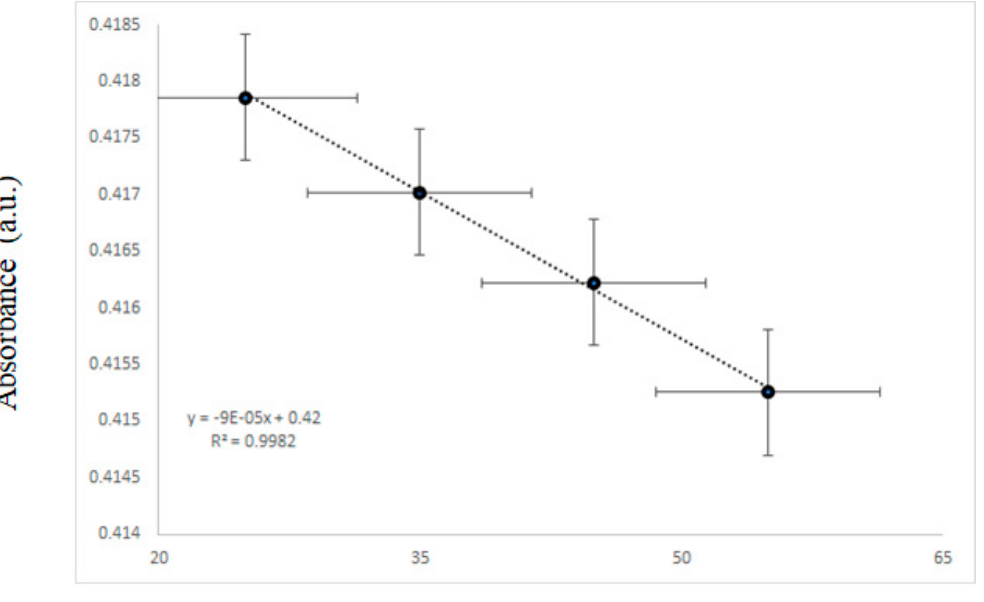
Figure 3. Linear regression between absorbance at 280 nm and scanning temperature. Please note that each dot represents the average of all whisky samples scanned at that temperature.